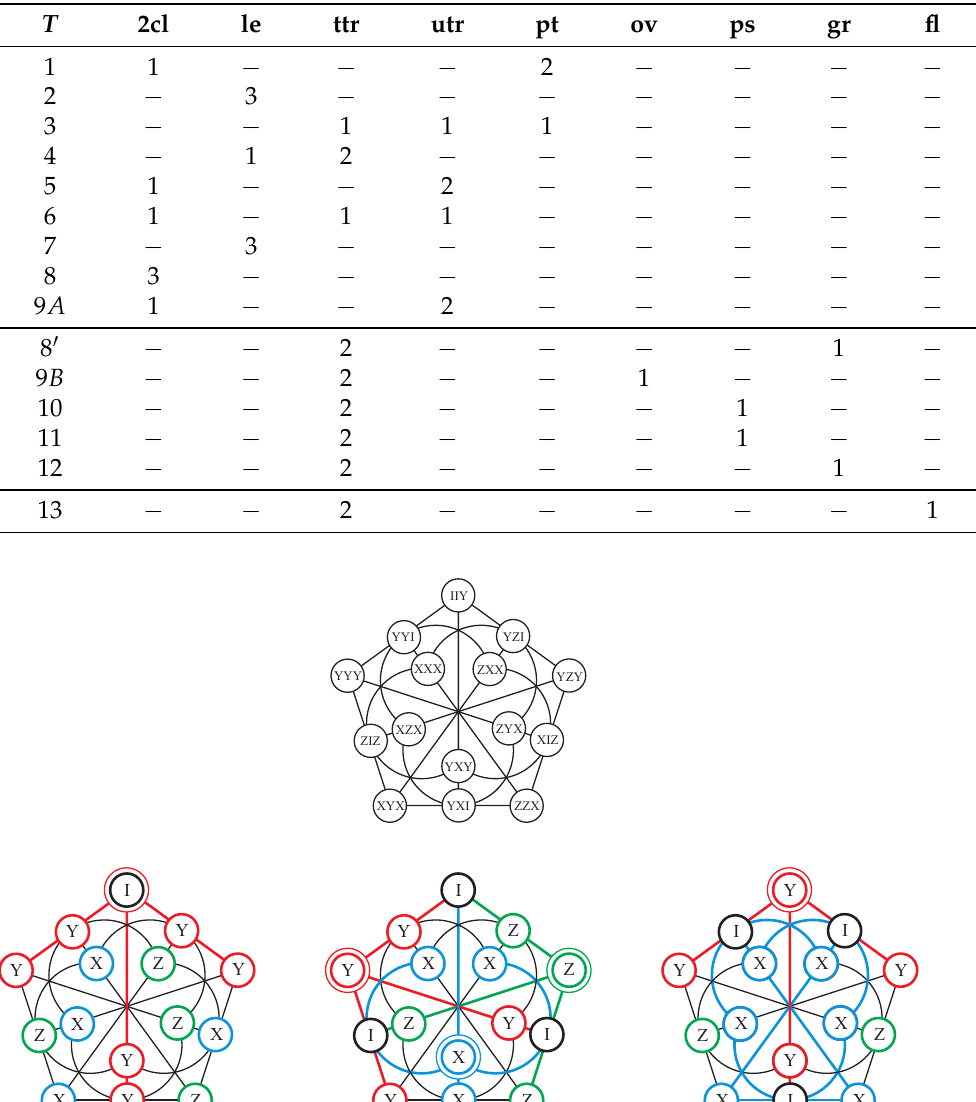
Table 4. A refined classification of doilies living in W ( 5,2 ) . We use the following abbreviations for the cores of Veldkamp lines: 2cl—two concurrent lines, le—line, ttr—tricentric triad, utr—unicentric triad, pt—point, ov—ovoid, ps—perp-set, gr—grid and fl stands for the full doily.